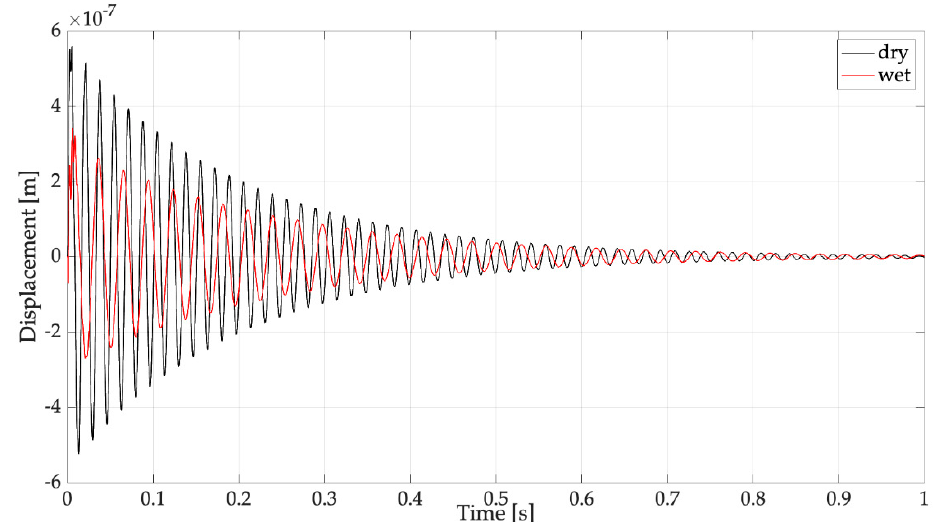
Figure 6. E ff ect of added mass on the cantilever tip displacement (dry: harvester with empty spoon, wet: spoon filled with water).